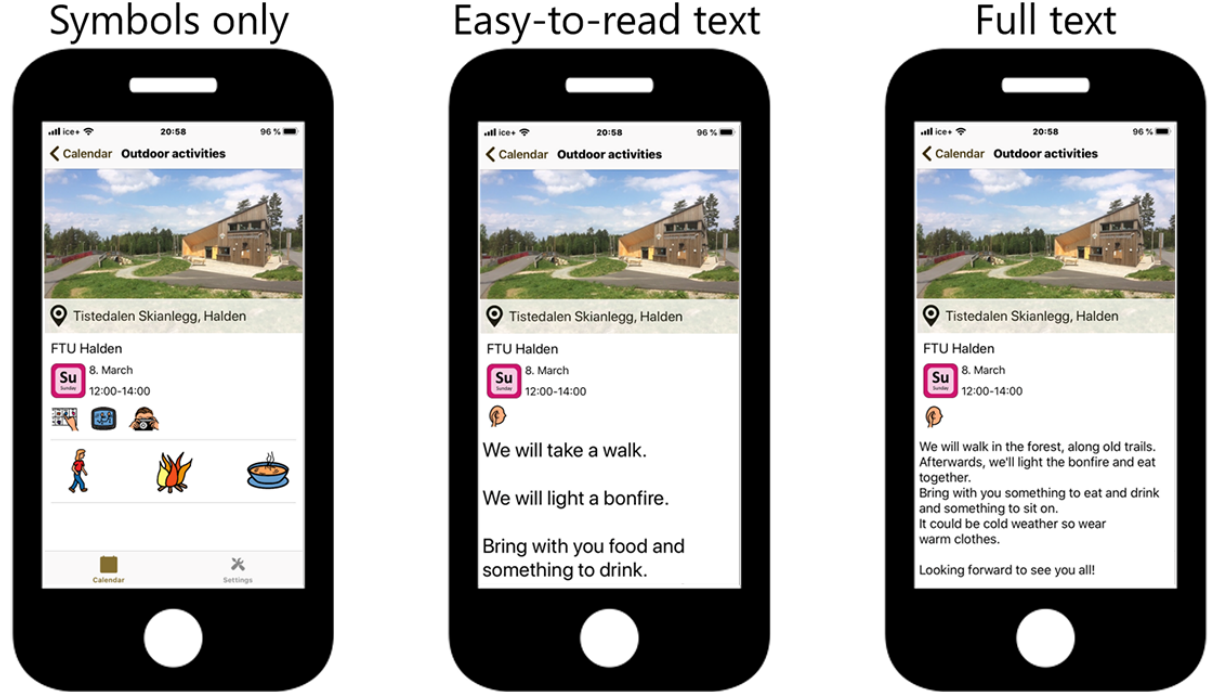
Figure 2. Interface options of the Actiplan app: symbols only, easy-to-read text, or plain text. The app also has read-aloud